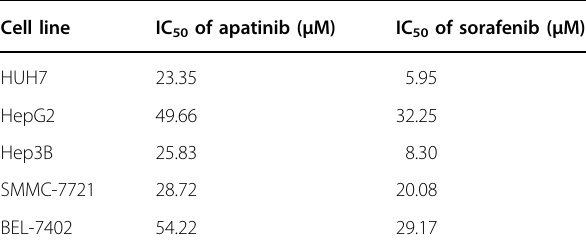
Table 1 Half-maximal inhibitory concentration (IC 50 ) of apatinib and sorafenib in hepatocellular carcinoma cell